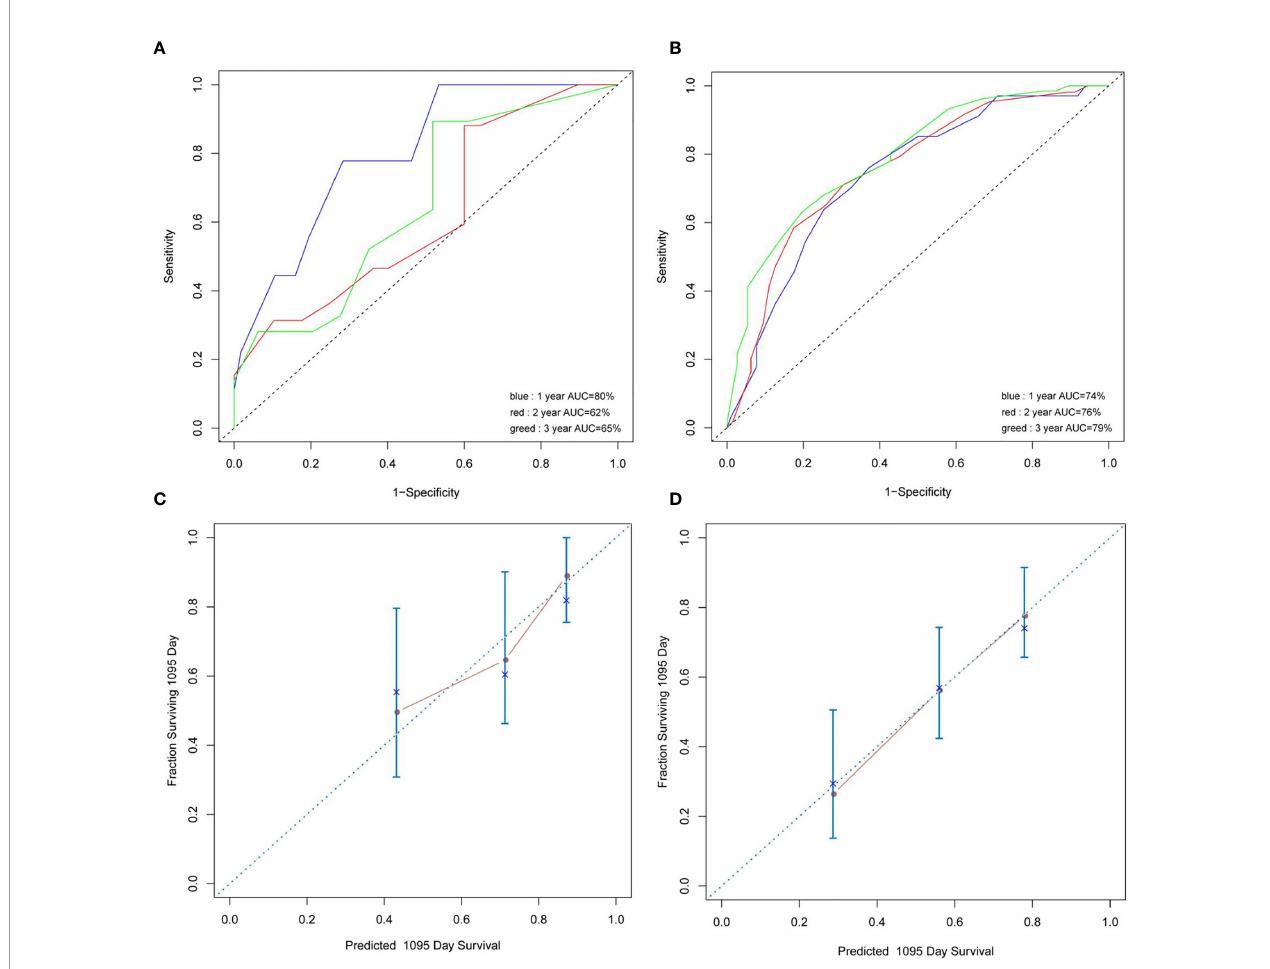
FIGURE 5 | (A, B) Concordance index showed the risk score ef fi cacy. (C, D) The calibration plots showed that the nomograms did well compared with an ideal